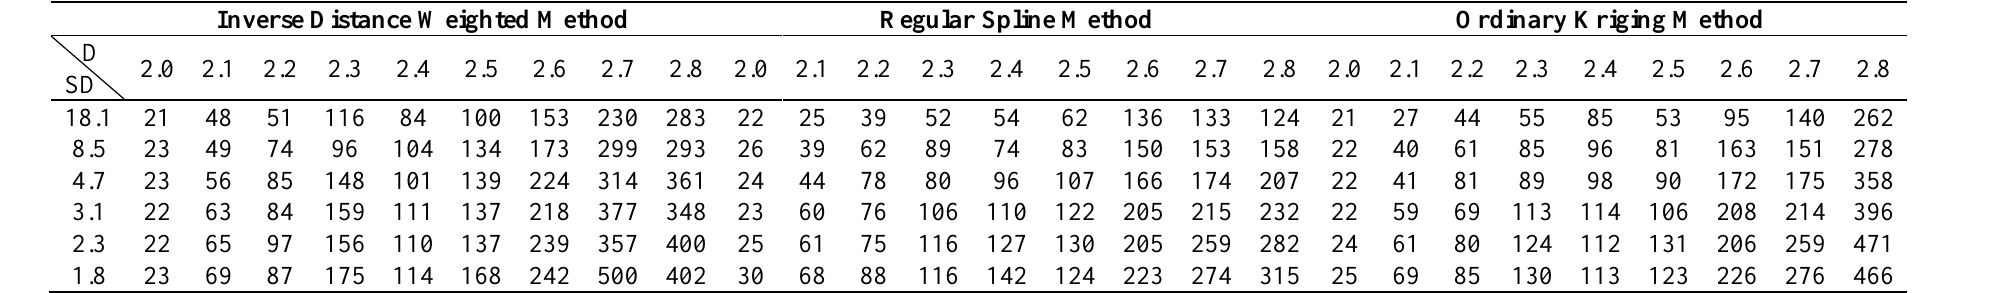
Table 1. The MAX s under the regular-grid sampling mode (Unit: m).